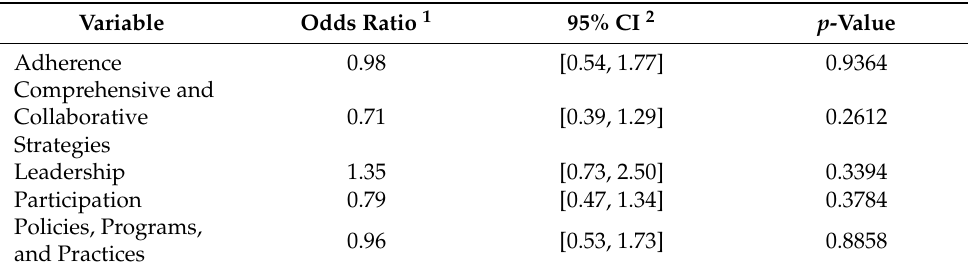
Table 3. Adjusted association between for-profit nursing home ownership and being in the bottom 25% percentile of WISH